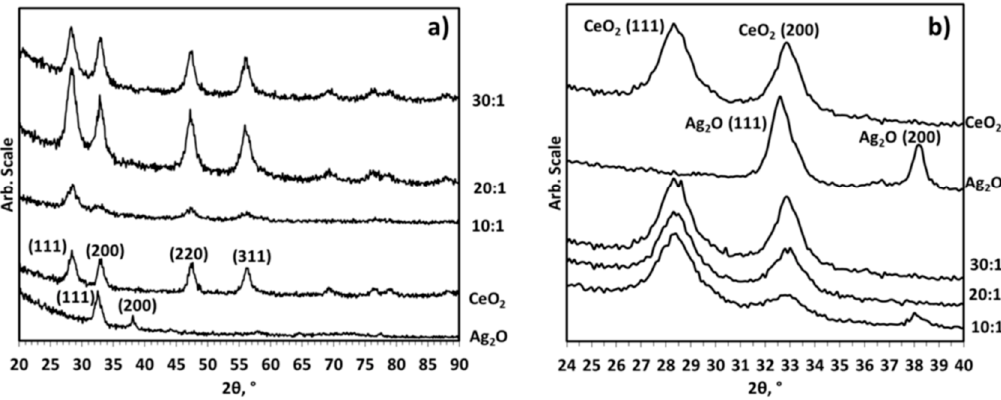
Figure 10. ( a ) X-ray diffraction (XRD) patterns of Ag 2 O, CeO 2 and Ag doped CeO 2 with different Ce:Ag ratios 10:1, 20:1, and 30:1 deposited at 200 °C. ( b ) XRD patterns of slow scans of CeO 2 , Ag 2 O and Ag doped CeO 2 with different Ce:Ag ratios 10:1, 20:1, 30:1 in the 2 θ range of 24°–40°.